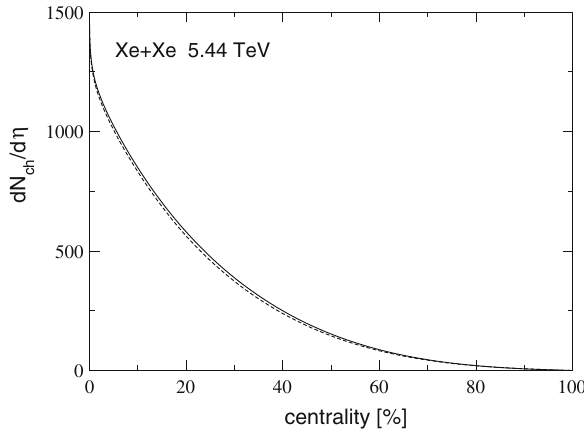
Fig. 2 Centrality dependence of midrapidity dN ch / d η for Xe + Xe √ s = 5 . 44 TeV obtained for the scenarios with (solid) collisions at mesoncloudat α = 0 . 09andwithout(dashed)mesoncloudat α = 0 . 13